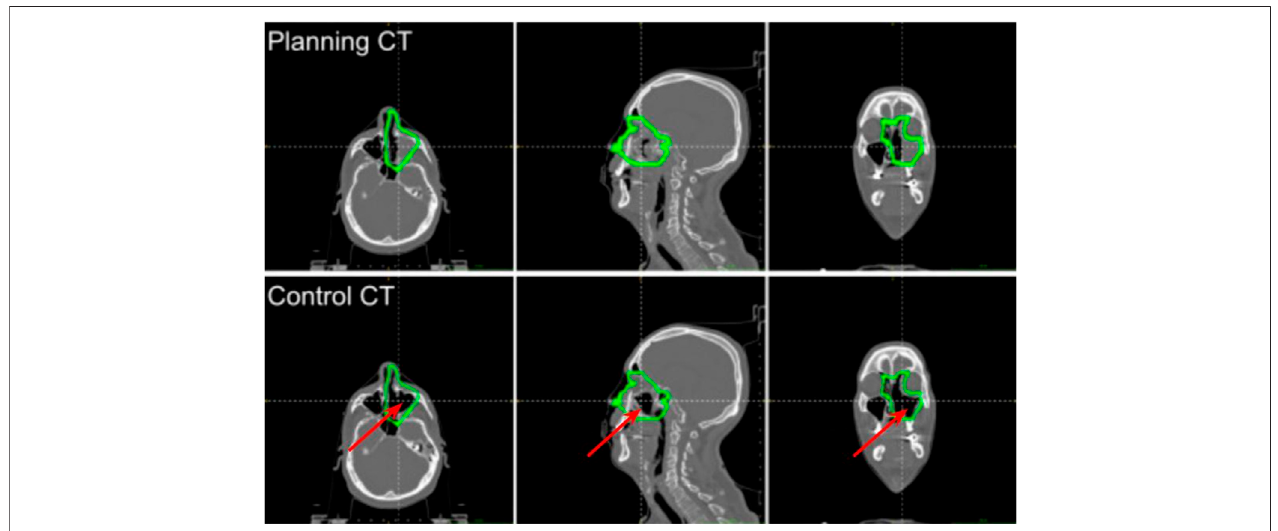
FIGURE1| Slices ofthe planning and controlCTsoftheMCP patient at the isocenter (fromleft toright: axial, sagittal, and coronal). The isocenter isat thecrossing point of the dashed lines. The CTV margins are drawn in green. The emptied region is pointed out with the red arrow.